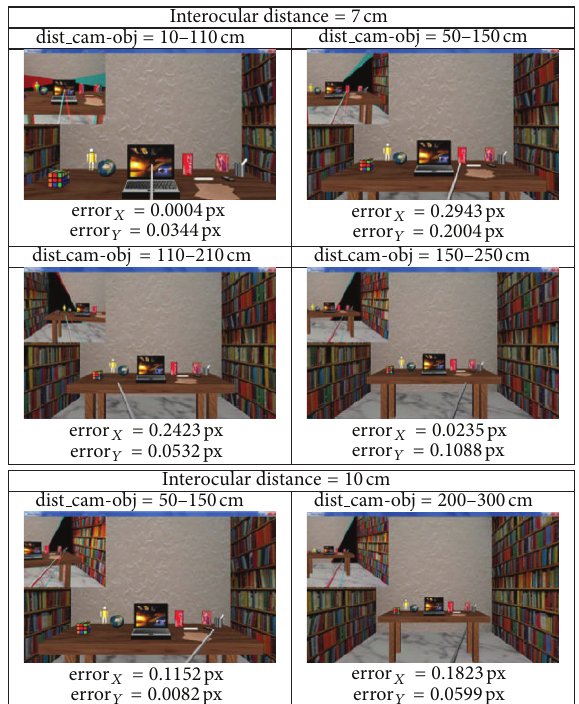
Figure 9: Snapshots of the performances obtained when a different inter-ocular distance and/or the distance between the vision system and the objects ranges is modified.